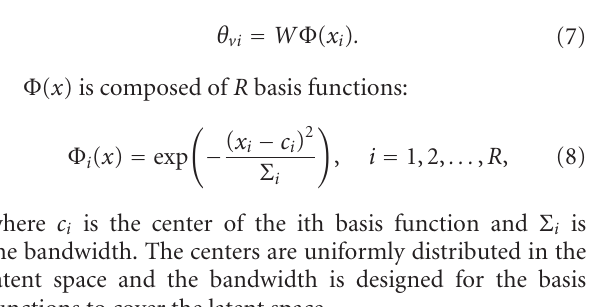
The sampled trajectory is projected from a 6-dimensional data space to a 2-dimensional space using the original ISOMAP algorithm and a modified ISOMAP algorithm in “feature extraction”